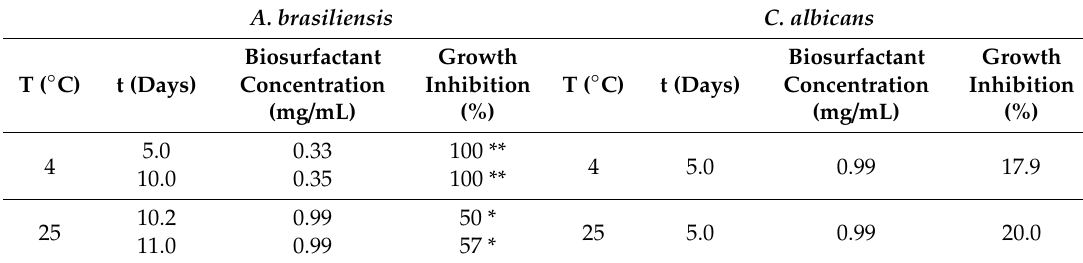
Table 4. Fungicidal and fungistatic conditions of the biosurfactant extracted from the CSW against A. brasiliensis and C. albicans in refrigerator storage (4 ◦ C) and room temperature (25 ◦ C) (* fungistatic e ff ect, ** fungicidal e ff